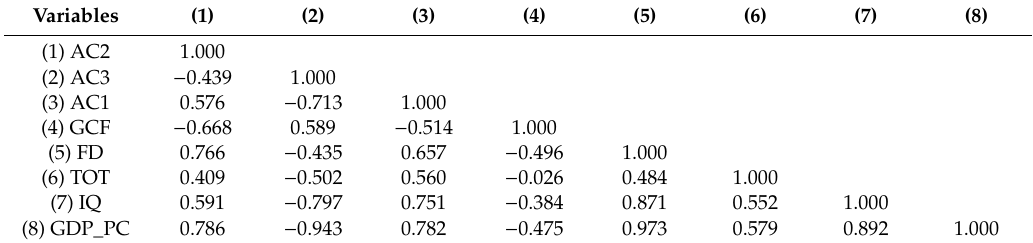
Table A2. Matrix of correlations (USA).